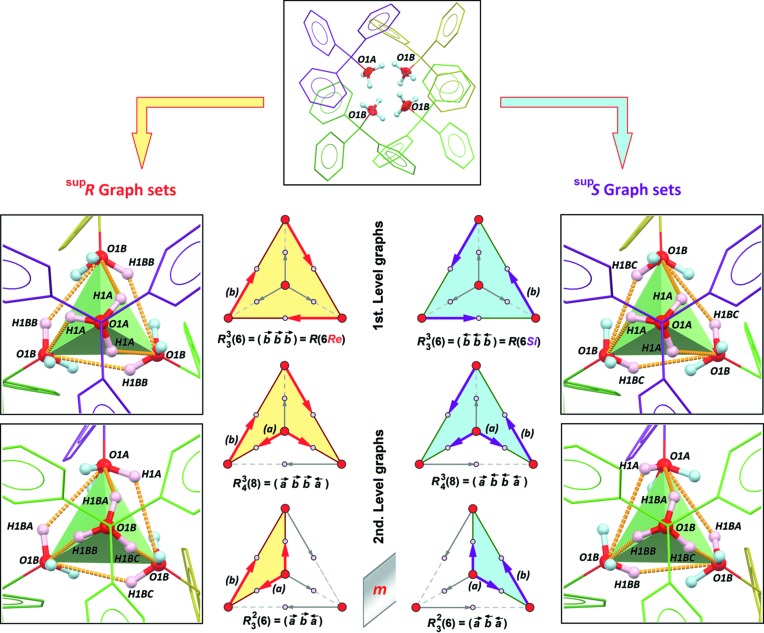
Hydrogen-bonding schemes in the tetra­mer formed by A/B mol­ecules. The top figure shows the arrangement of the four mol­ecules and the 12 hy­droxy H-atom sites. The left and right panels represent right- (sup
R) and left-handed (sup
S) supra­molecular clusters, respectively. The first figure is oriented down the crystallographic threefold axis and the other is oriented down a noncrystallographic threefold axis. Each cluster comprises six hydrogen bonds (dashed gold bonds), involving six H-atom sites (pink H atoms). Topological graphs G(4,6) for supra­molecular clusters based on O—H⋯O hydrogen bonds are represented in the centre. Nodes are represented as red balls (O atoms). Arrows forming a ring Rda(n) are stacked over O—H covalent bonds and oriented in the direction d→a, where d is the donor and a the acceptor for a hydrogen bond. Arrows involved in a ring are shown in bold, while those not participating in a ring are greyed out. Polygons delimited by R rings in the 2-space are coloured yellow and blue for sup
R and sup
S clusters, respectively, and rings in the projection plane are read clockwise in all cases. For the first-level graphs, Re stands for Rectus and Si for Sinister. Note that all figures on the left are mirror images of the figures on the right, including descriptors of the R rings.